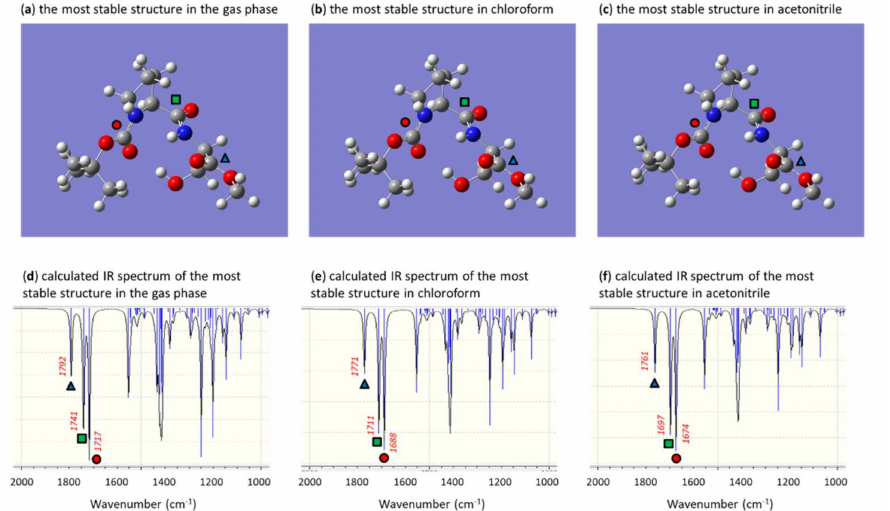
Figure 17. The most stable structure and calculated IR spectra of N -Boc-L-proline-L-serine-OMe 7 : ( a ) The most stable structure in the gas phase; ( b ) the most stable structure in chloroform; ( c ) the most stable structure in acetonitrile; ( d ) calculated IR spectrum in the gas phase; ( e ) calculated IR spectrum in chloroform; ( f ) calculated IR spectrum in